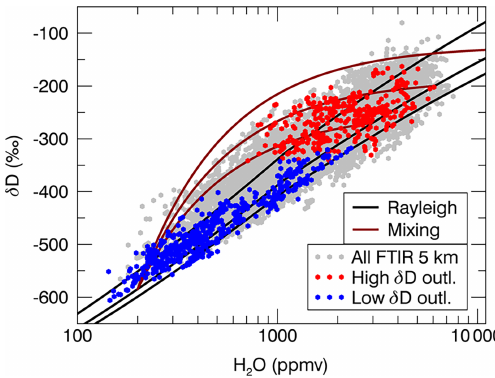
Figure 5. Free-tropospheric measurements of {H 2 O, δ D} pairs above Zugspitze (5kma.s.l.) for all 2005–2015 data and for high and low δ D outliers as determined from the deseasonalized column- based δ D time series. For comparison, simulated Rayleigh pro- cesses (initial evaporation at T = 15 ◦ C; RH = 80%; δ D val- ues of − 60, − 130, and − 160‰) as well as mixing processes = 200ppmv, δ D = − 585‰) of upper-tropospheric air (VMR H 2 O = with three lower–middle-tropospheric air masses ((i) VMR H 2 O = 6100ppmv, δ D = 13500ppmv, δ D = − 130‰; (ii) VMR H 2 O − 200‰; (iii) VMR = 3000ppmv, δ D = − 270‰) are H 2 O